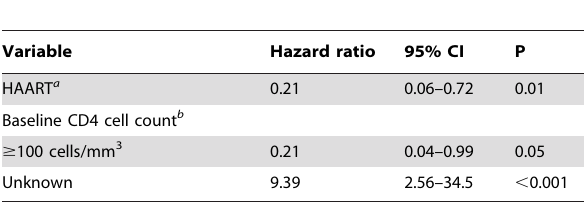
Table 3. Variables Associated with Early Tuberculosis-Related Mortality in Multivariate